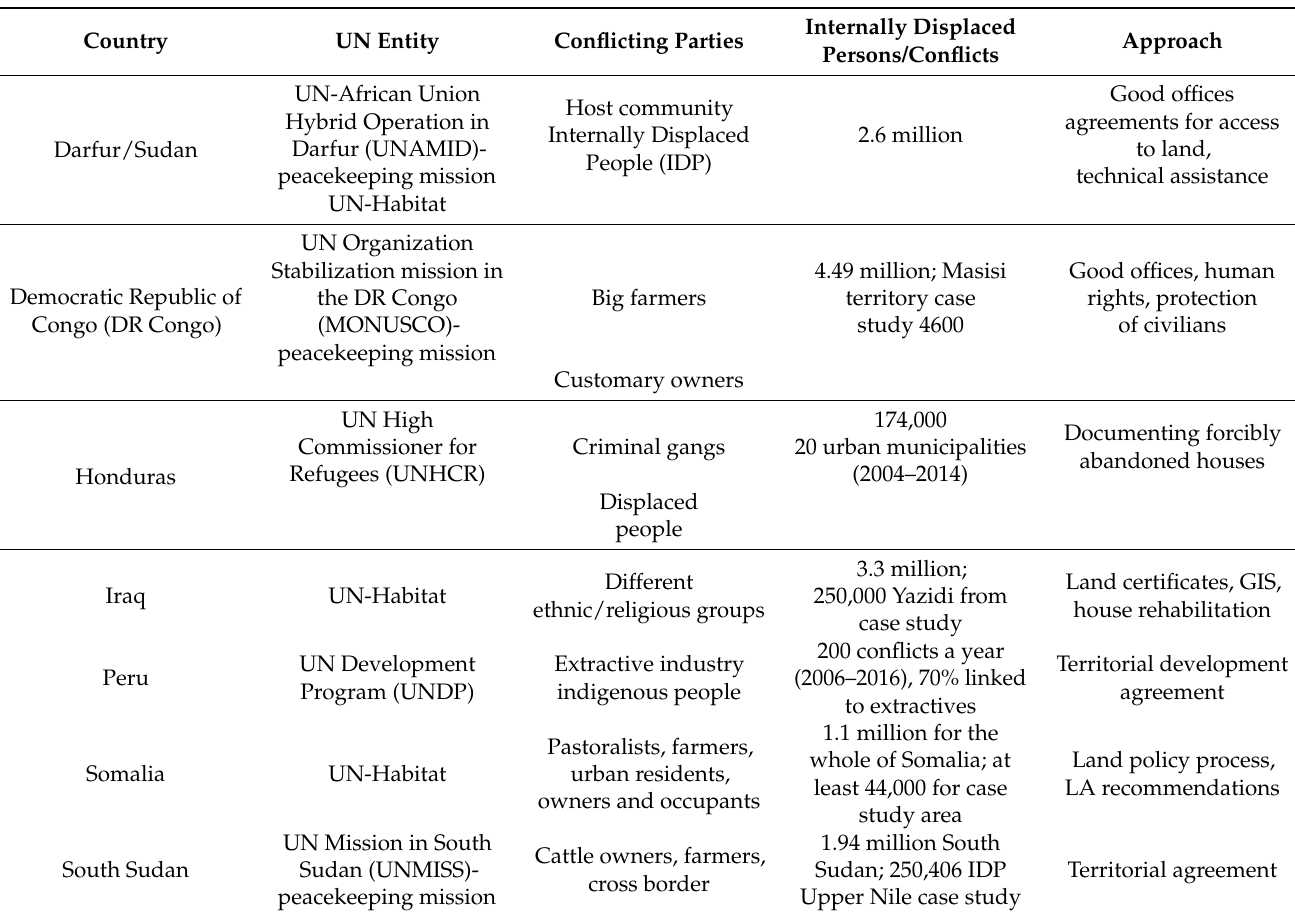
Table 1. Seven country cases [4] (pp. 13, 71),